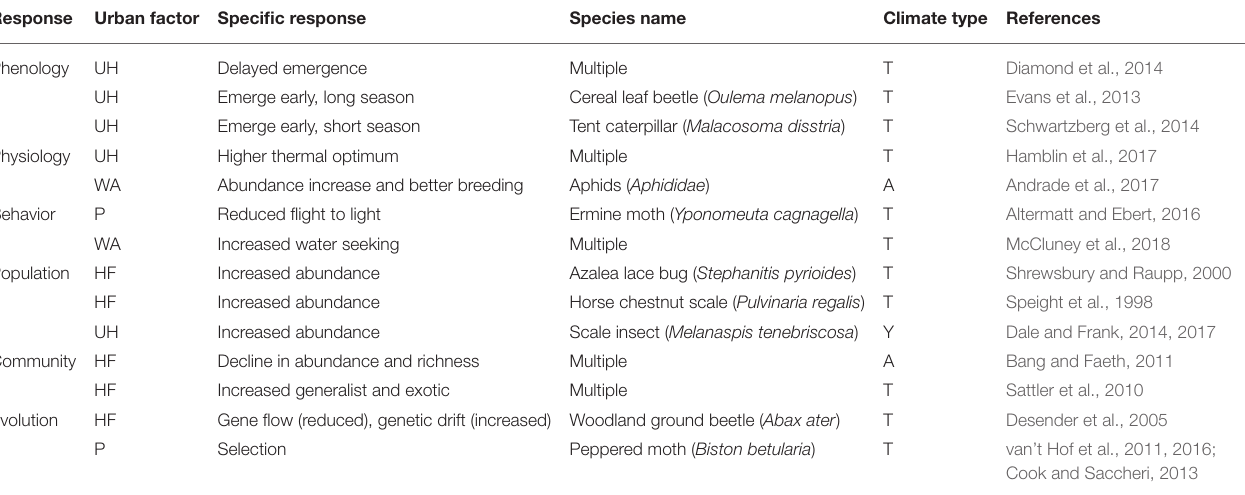
TABLE 1 | Examples of ecological and evolutionary responses to urbanization for herbivorous